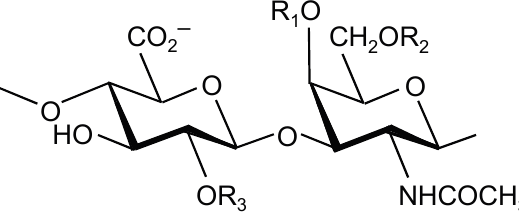
Figure 1. Structures of disaccharides forming chondroitin sulfate. R 1 = R 2 = R 3 = H: non-sulfated chondroitin. R 1 = SO 3 − ; R 2 = R 3 = H: chondroitin-4-sulfate; R 1 = R 3 = SO 3 − ; R 2 = H: chondroitin-2,4-disulfate; R 2 = SO 3 –; R 1 = R 3 = H: chondroitin-6-sulfate; R 2 = R 3 = SO 3 − ; R 1 = H: chondroitin-2,6-disulfate; R 1 = R 2 = SO 3 − ; R 3 = H: chondroitin-4,6-disulfate; R 1 = R 2 = R 3 = SO 3 − : trisulfated